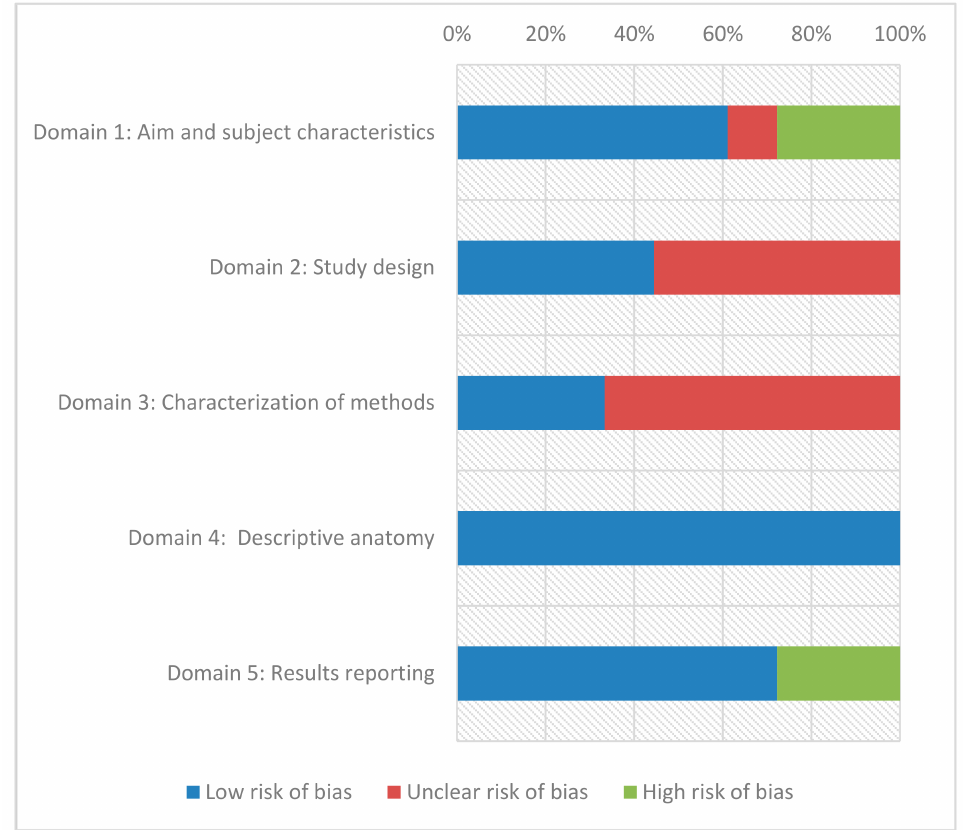
Figure 2. Risk of bias assessment for individual domains using the AQUA